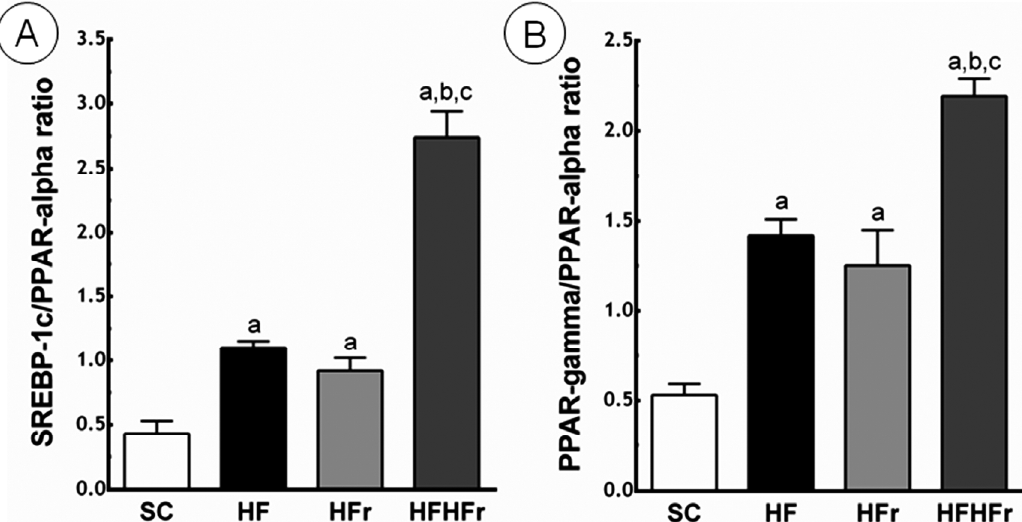
Figure 4. ( A ) Sterol regulatory element-binding proteins (SREBP)-1c/peroxisome proliferator-activated receptors (PPAR)- α ratio; ( B ) PPAR- γ /PPAR- α ratio. Expressed in arbitrary units, a.u. SC, HF, HFr and HF/HFr. Values are means ± standard error. There was a significant difference ( p ≤ 0.05) compared with the a SC group; b HF group; and c HFr